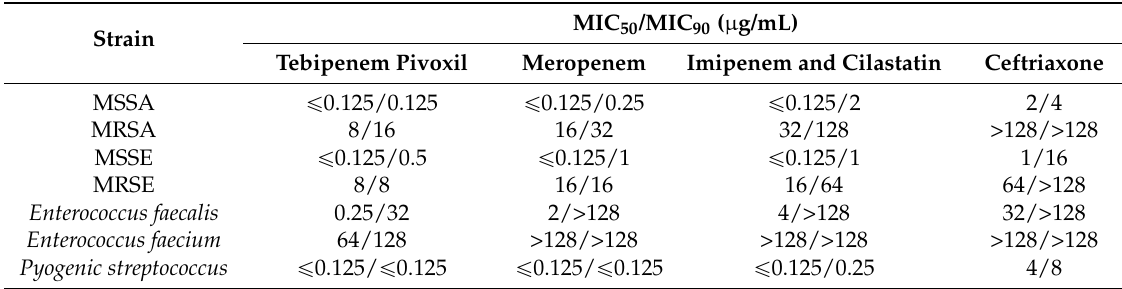
Figure 1. Cumulative inhibition curves of tebipenem pivoxil and other antibiotics against gram-positive bacteria tested. Table 1. MICs of tebipenem pivoxil and other antibiotics against tested Gram-positive bacteria. Strain